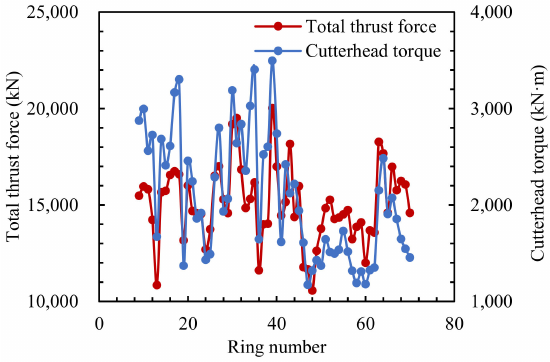
Figure 14. Variation in the total thrust force and cutterhead